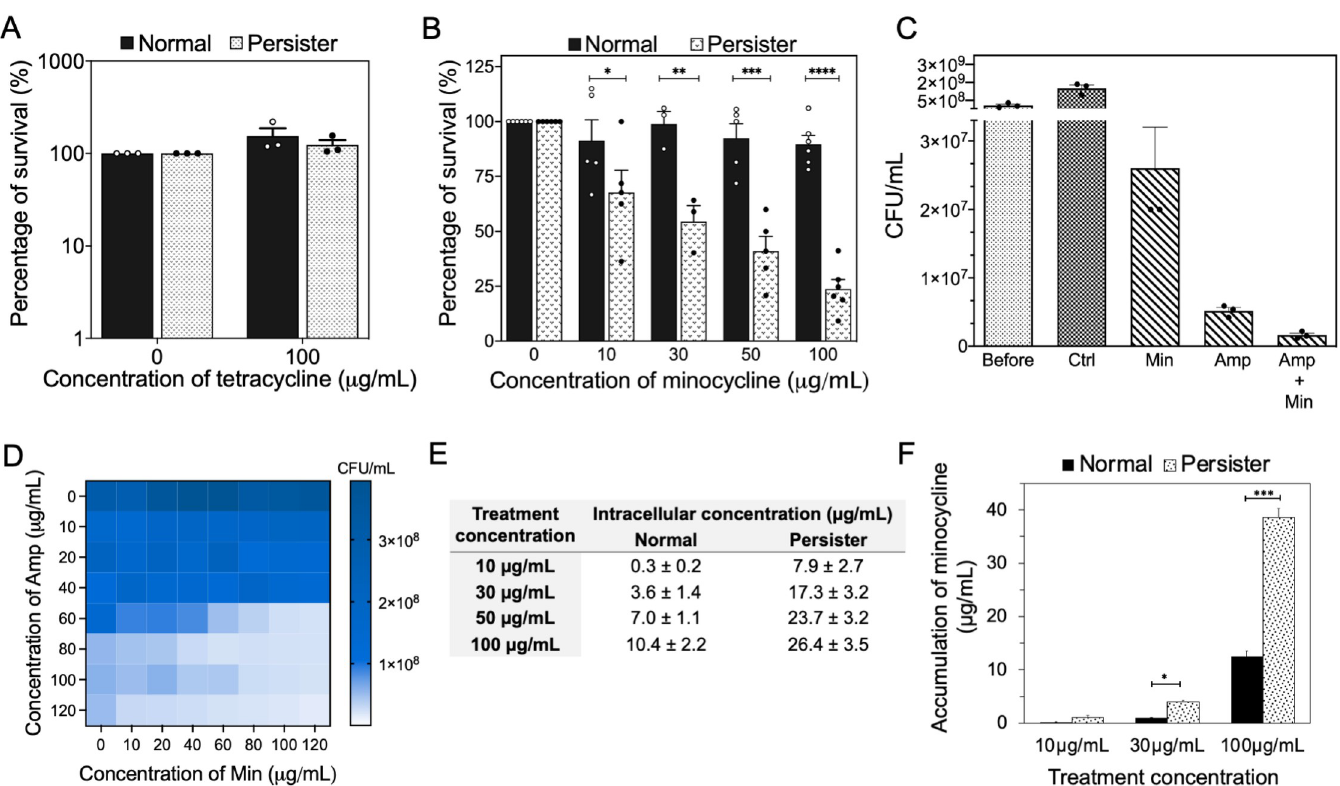
Fig 1. Minocycline is more effective against E . coli HM22 persister cells than normal cells. (A) Viability of E . coli HM22 persister and normal cells after tetracycline treatment in PBS. (B) Effects of minocycline (in PBS) on the viability of normal (black bars) and persister (white bars) cells of E . coli HM22. The untreated samples from each population were normalized as 100%. Means ± SE are shown (n = 5). (C) Different antibiotic treatments of E . coli HM22 persister cells including 100 μ g/mL of ampicillin, 100 μ g/mL of minocycline, and the combination of both treated in LB medium. (D) The effects were corroborated by a checkerboard assay. The exponential phase cells were treated with ampicillin for 3 h in LB, followed by treatment with minocycline for 1 h in PBS. (n = 2) (E) Intracellular concentration of minocycline based on the reporter bioassay. Minocycline concentration was calculated using a standard curve of reporter strain for each population (S1 Fig). Means ± SE are shown (n = 4). (F) Intracellular concentration of minocycline from treated and untreated samples in both normal (black bars) and persister (patterned bars) populations using LC-MS. Means ± SE are shown (n = 3). � p -value � 0.05, �� p -value � 0.01, ��� p -value � 0.001, ���� p -value � 0.0001.